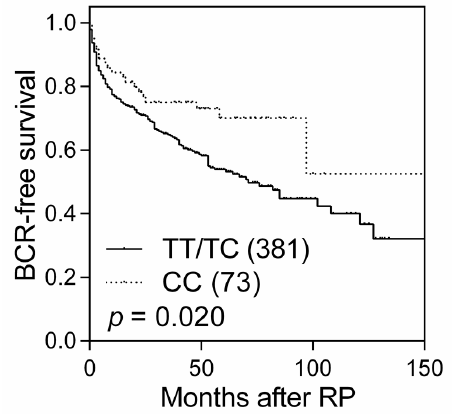
Figure 1. Kaplan-Meier curves comparing BCR-free survival by MTHFR rs9651118 genotypes. Numbers in parentheses indicate the number of patients. RP, radical prostatectomy.